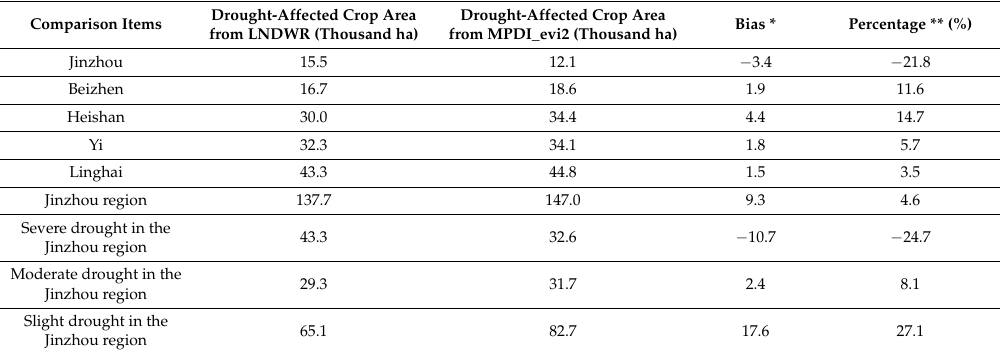
Drought-affected crop area by LNDWR and the EVI2-based MPDI model, as well as